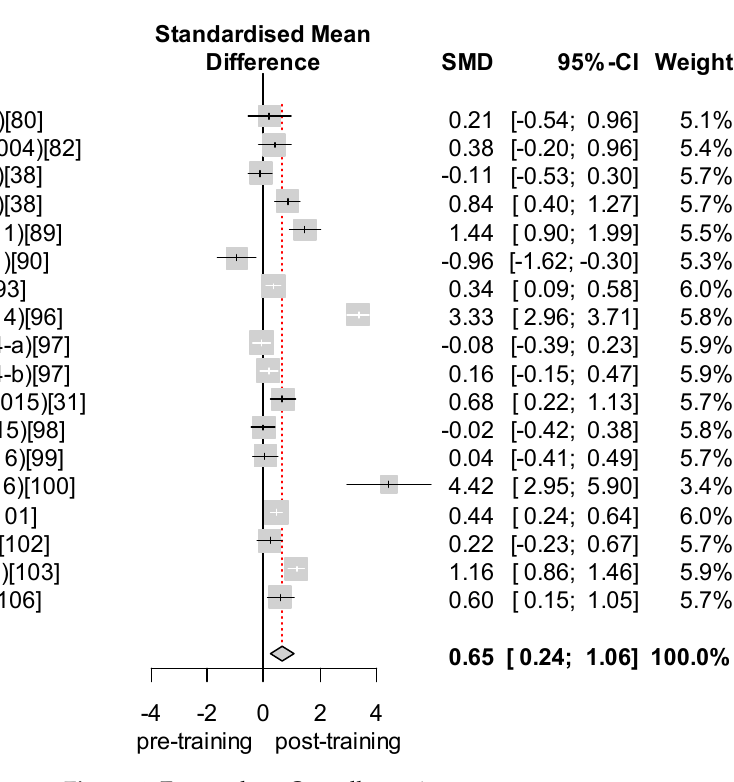
Figure 4. Forest plot—Overall practice.